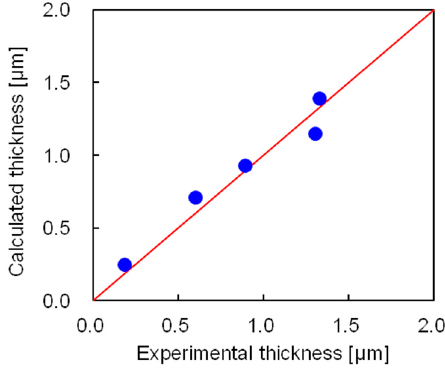
Figure 11. Comparing the experimental and calculated thicknesses of coating films.